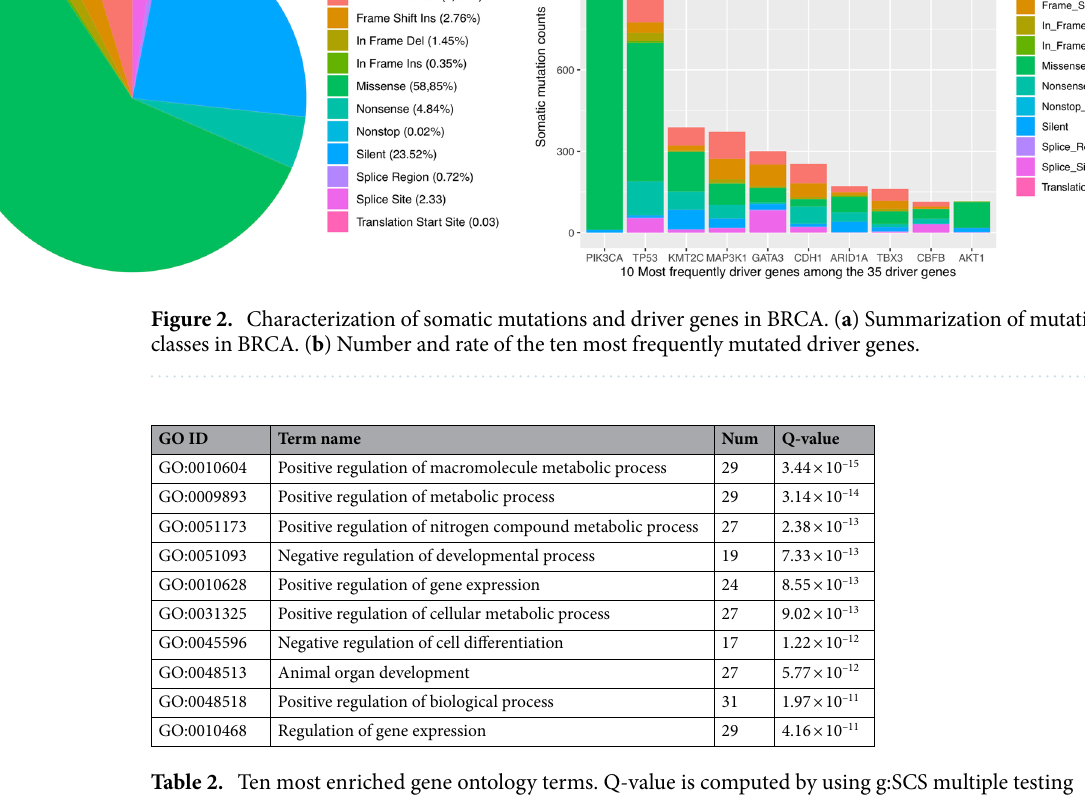
Table 2. Ten most enriched gene ontology terms. Q-value is computed by using g:SCS multiple testing correction method. Abbreviation: Num, Number of genes involving in the term.